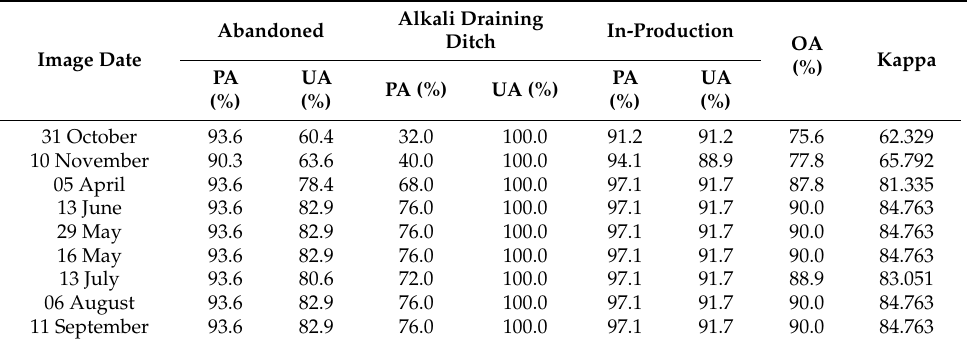
Table 7. Classification accuracies were generated by Model 2 as images were gradually added from high to low based on their date